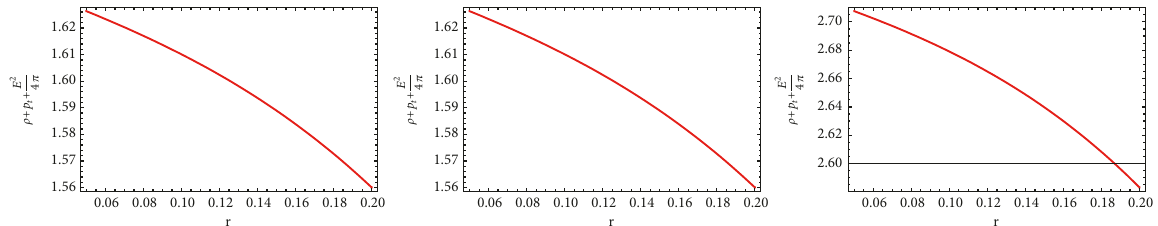
0.06 0.08 0.10 0.12 0.14 0.16 0.18 Figure 13: This figure represents the variation of 𝜌 + 𝑝 𝑡 + 𝐸 2 /4𝜋 versus 𝑟 (km) for the strange star taking 𝛽 = 1 , 𝛽 = 2 , and 𝛽 = 3 .